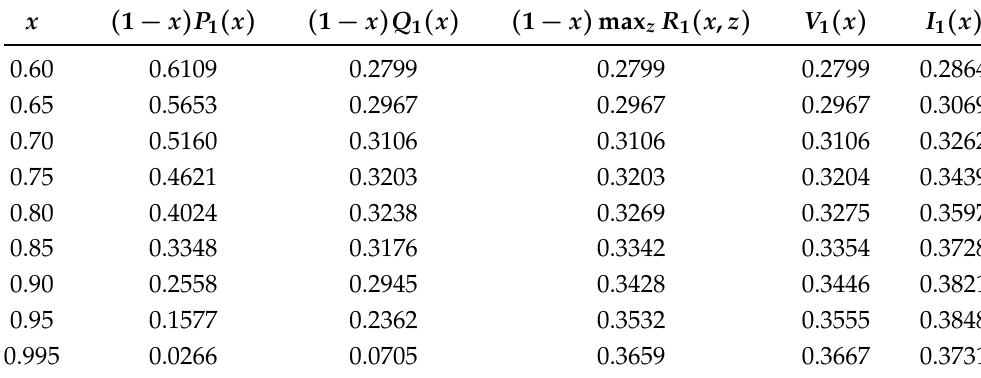
Table 2. Winning probability and bounds for k = 1.